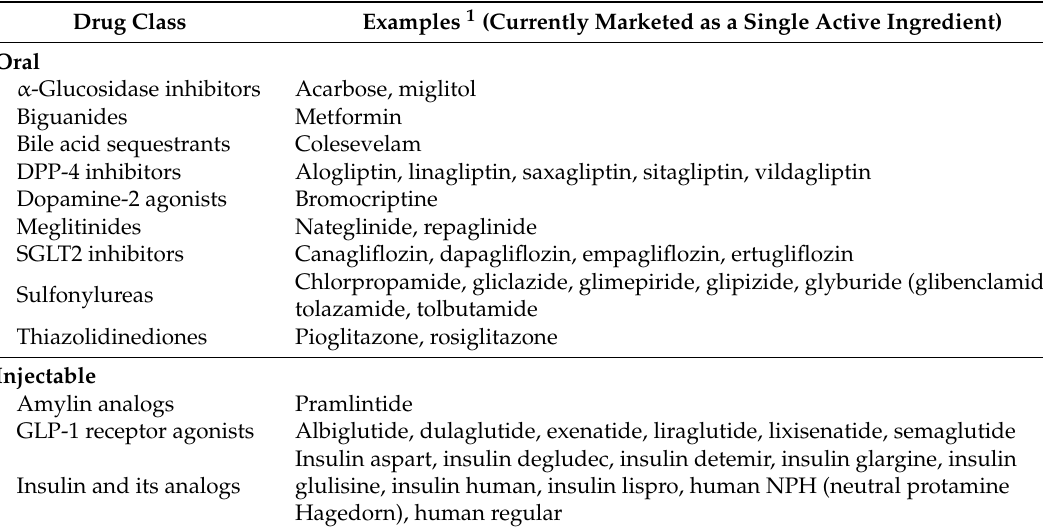
Table 1. List of drug classes available for the treatment of type 2 diabetes (T2D). Drug